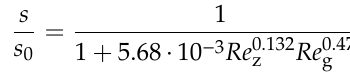
Figure 12. The liquid film thickness in downward two-phase air and oil viscosity η l = 0.371 Pas in pipe d = 0.022 m.